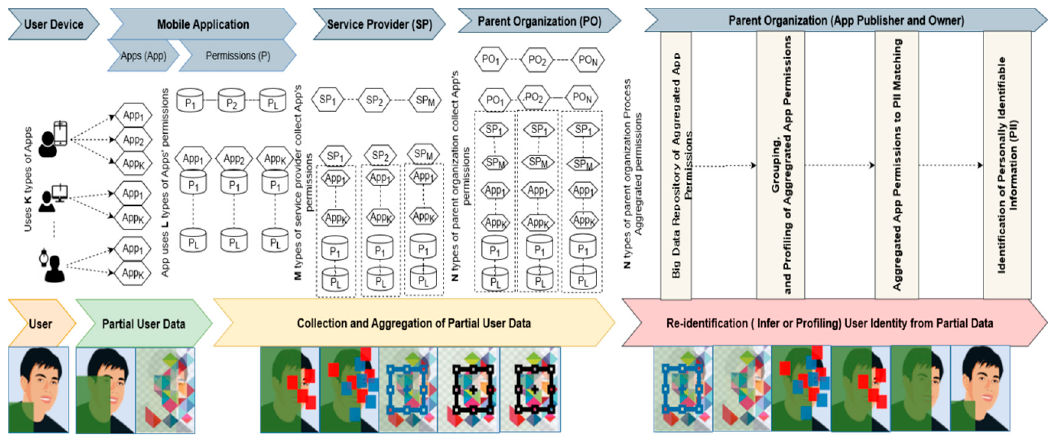
Figure 1. Application permission aggregation caused identity revealing by the parent organization.